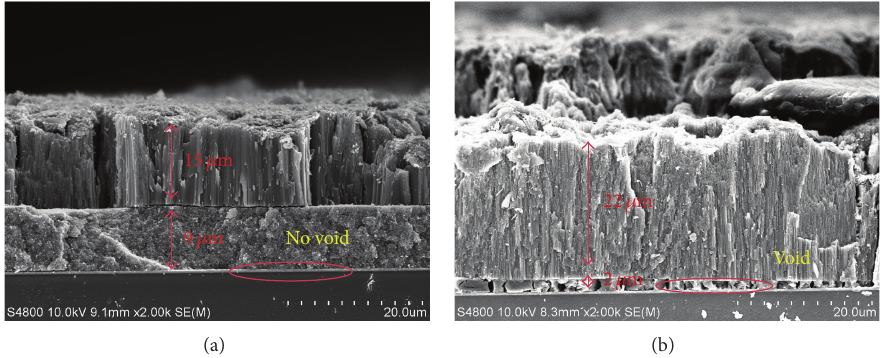
Figure 4: SEM images of cross-section of double-layer composite film (a) and TNT-arrays film